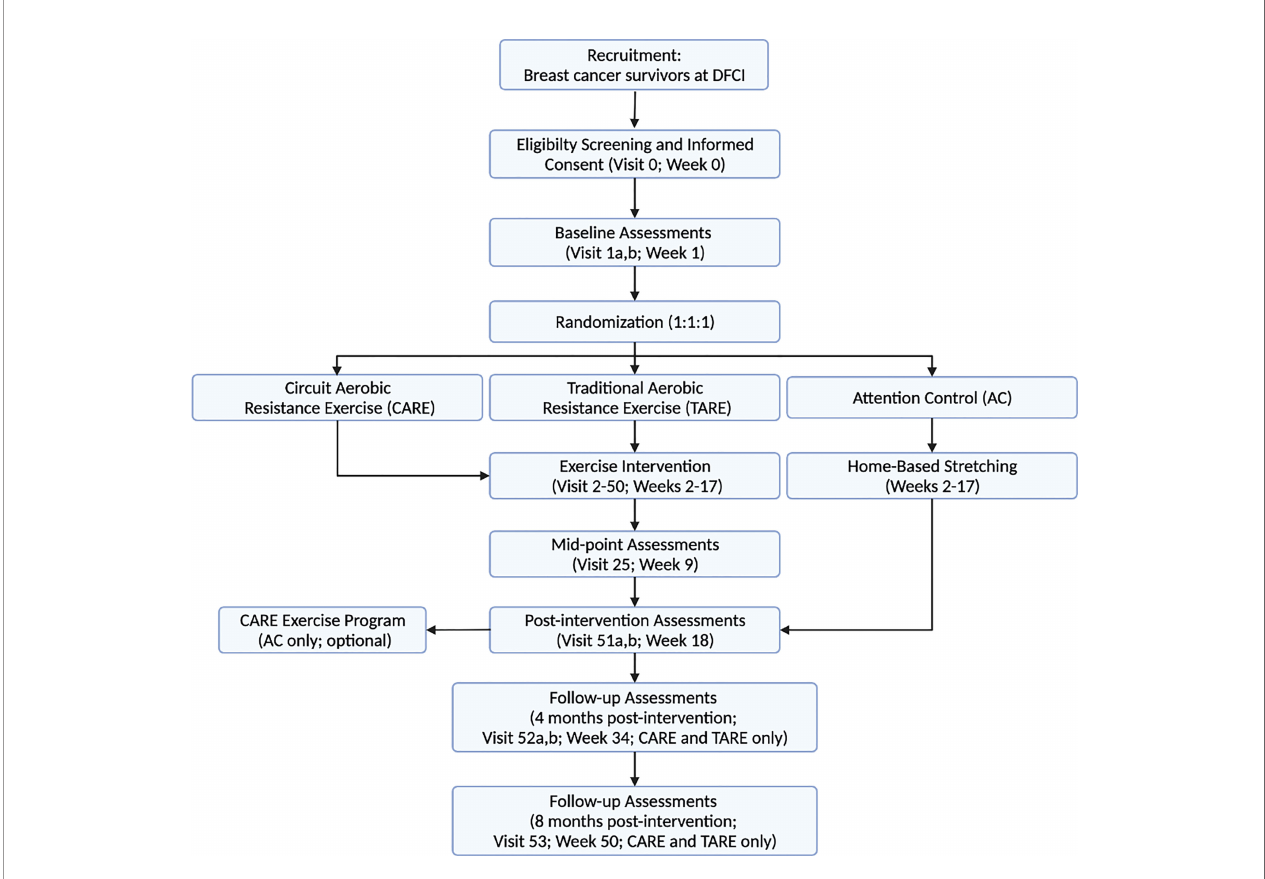
FIGURE 2 | CONSORT fl ow diagram of the AIM